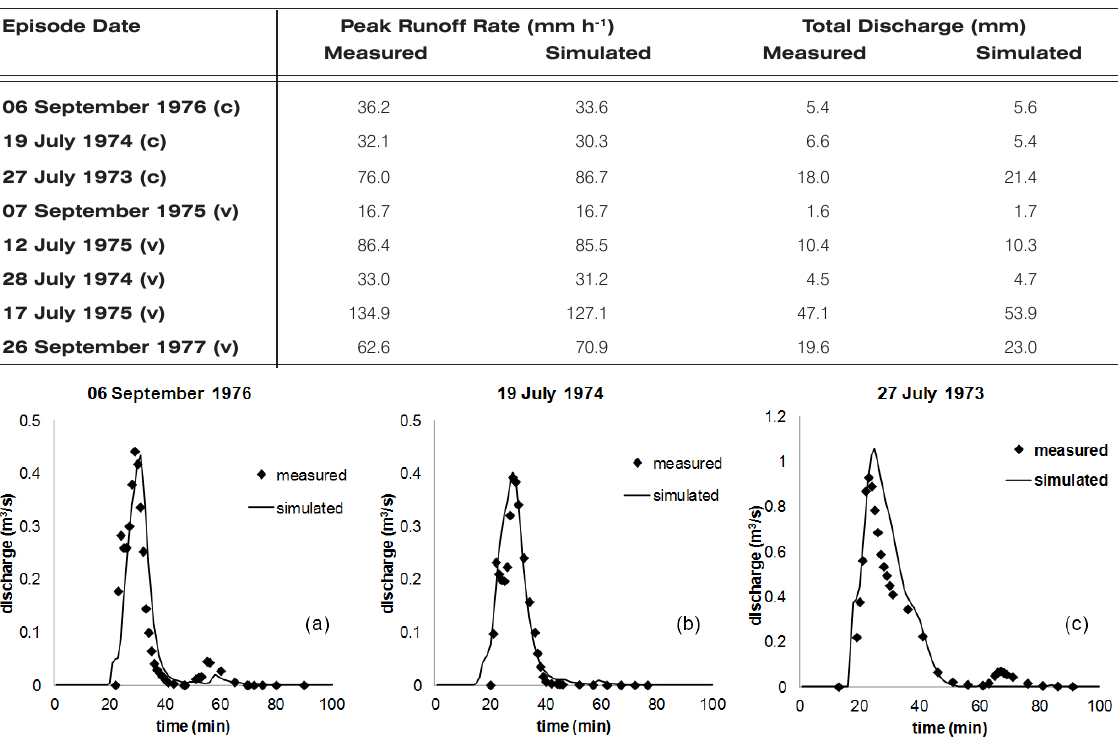
Table 1. Measured and simulated peak runoff rate and total discharge for the calibrated /validated episodes.